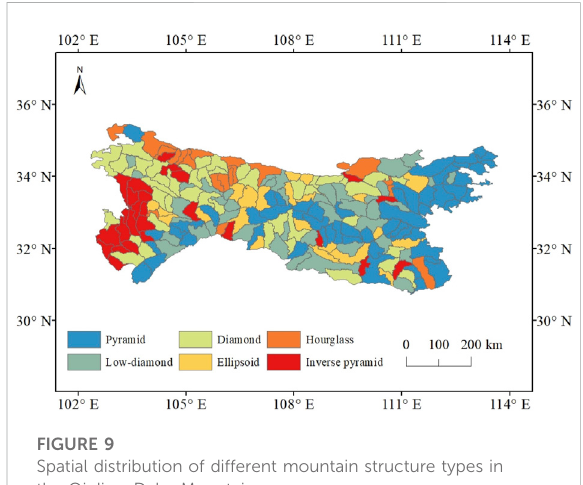
FIGURE 9 Spatial distribution of different mountain structure types in the Qinling-Daba Mountains.